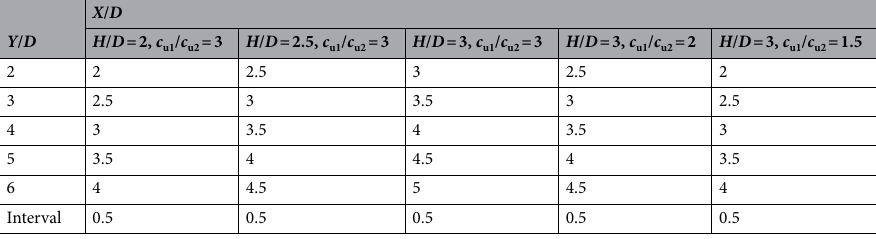
Table1. X / D of worst cases with different parameters.